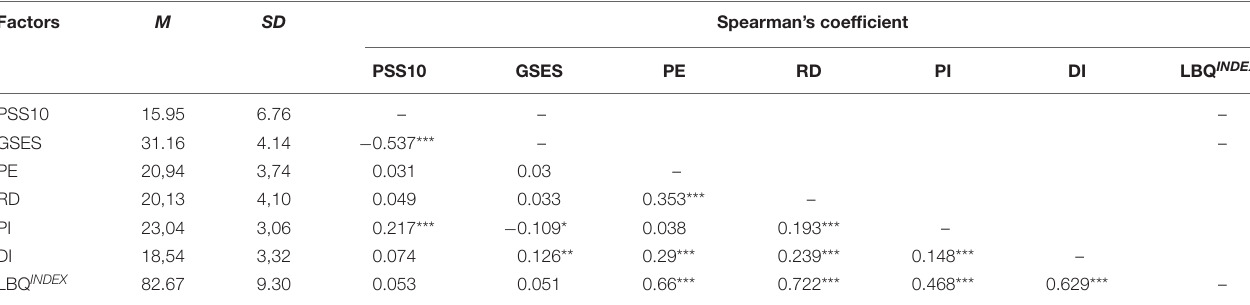
TABLE 1 | The correlations among perceived stress, occupational burnout and